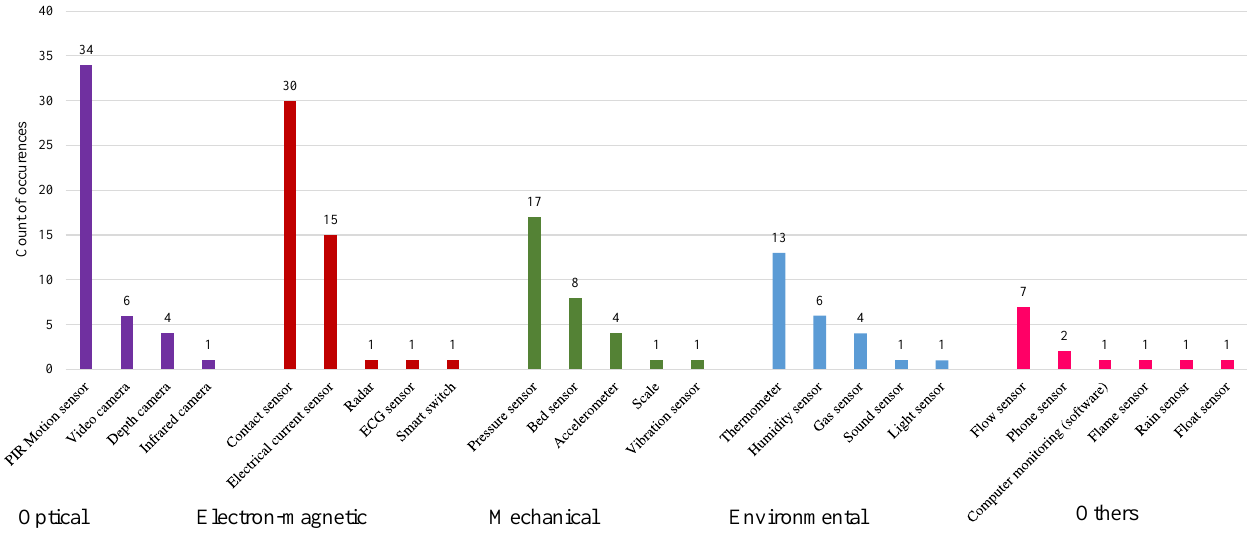
Figure 3. Connections between sensors and their locations. A wider connection indicates more included papers supporting the connection in this review. The terms in the same category are illustrated in the same color.